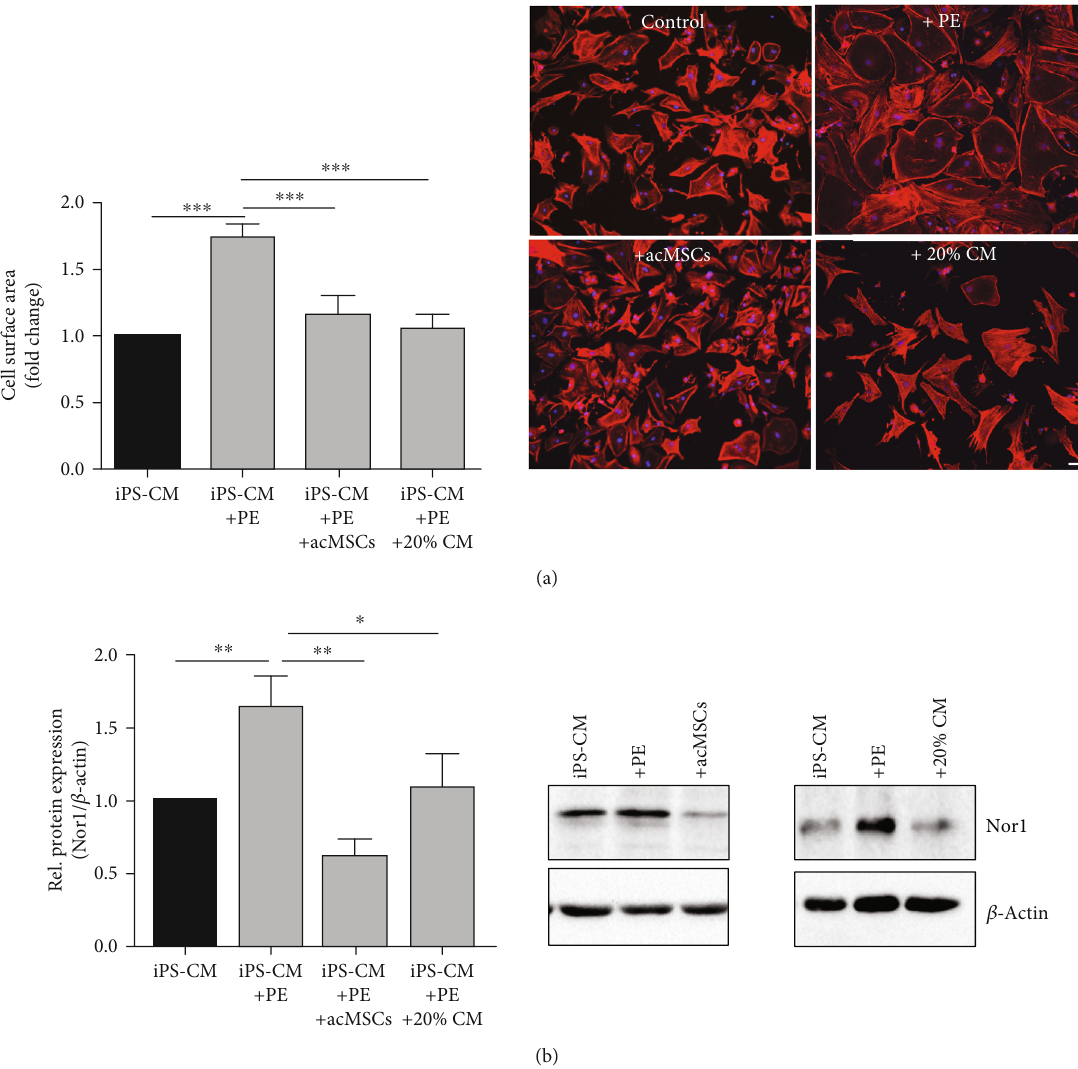
Figure 3: MSC-derived soluble mediators induce hypertrophy regression in iPS-CM. Bone marrow-derived MSCs were stimulated with 30ng/ml IFN- γ and 3ng/ml IL-1 β for 24h. Then, preconditioned MSCs (acMSCS) were indirectly cocultured with hypertrophied iPS- CM. In some experiments, hypertrophied iPS-CM were cultured in medium supplemented with 20% MSC-conditioned medium (CM). (a) Cell area quanti fi cation in iPS-CM was performed by immuno fl uorescent staining. Representative images are displayed. Bar: 100 μ m. n = 6 . (b) Nor1 protein expression in iPS-CM. n = 5 . ∗ p < 0 : 05 , ∗∗ p < 0 : 01 , and ∗∗∗ p < 0 : 001